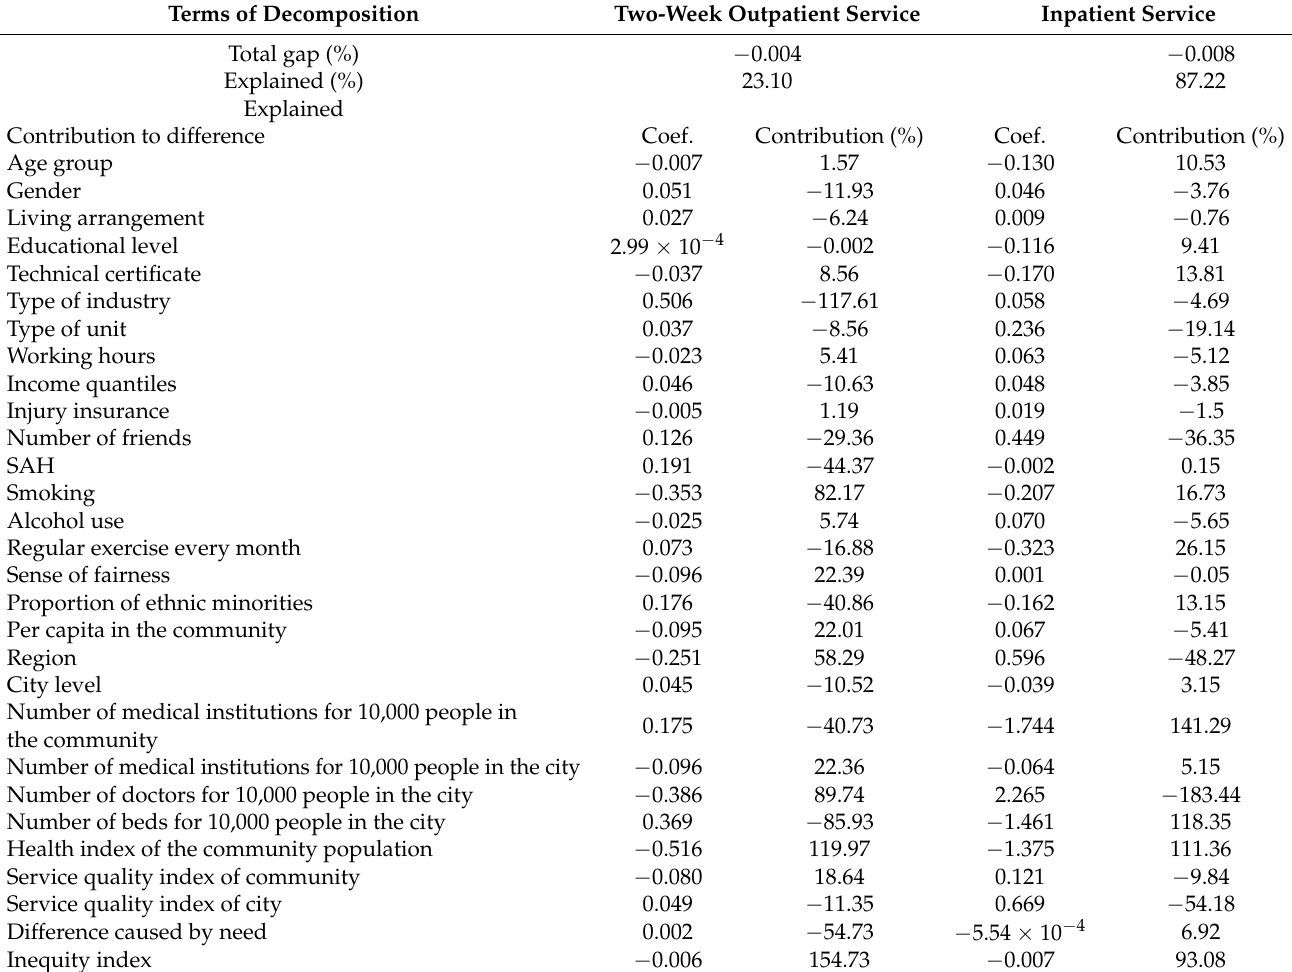
Table 5. Fairlie’s decomposition of the difference of health service utilization between the matched